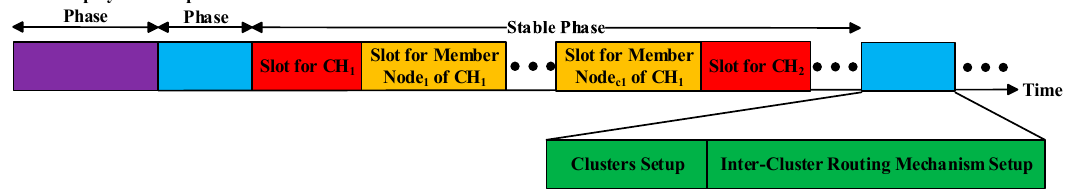
Figure 5. The time slot allocation of the clustering protocol. CH—cluster head.